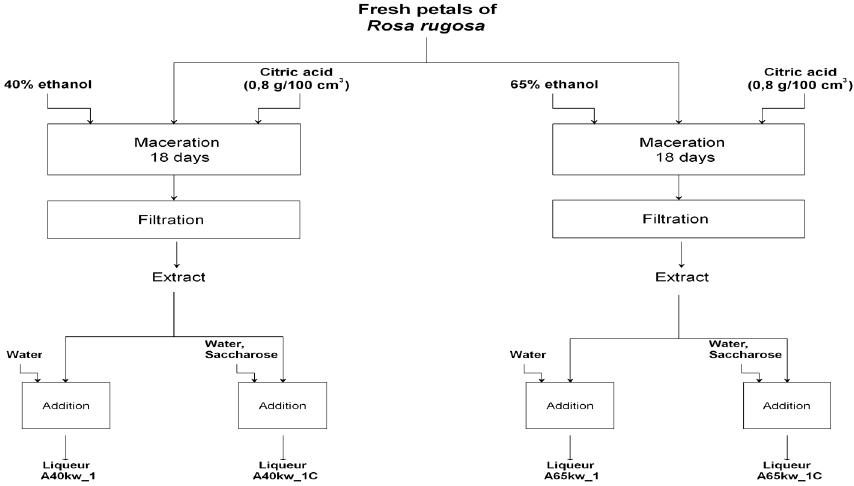
Figure 2. Diagram of the technological operations for liqueurs prepared from acidified Rosa rugosa petal extract.